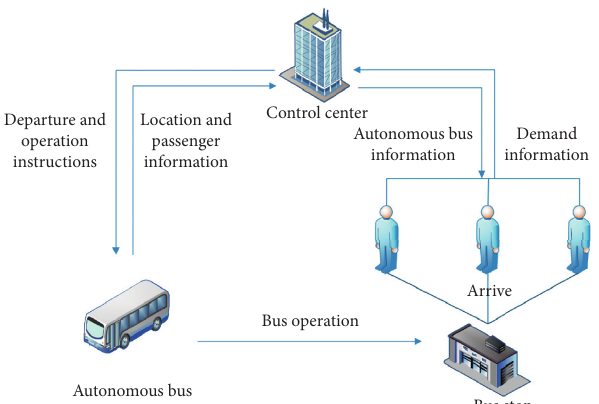
Figure 3: Autonomous bus-on-demand system.